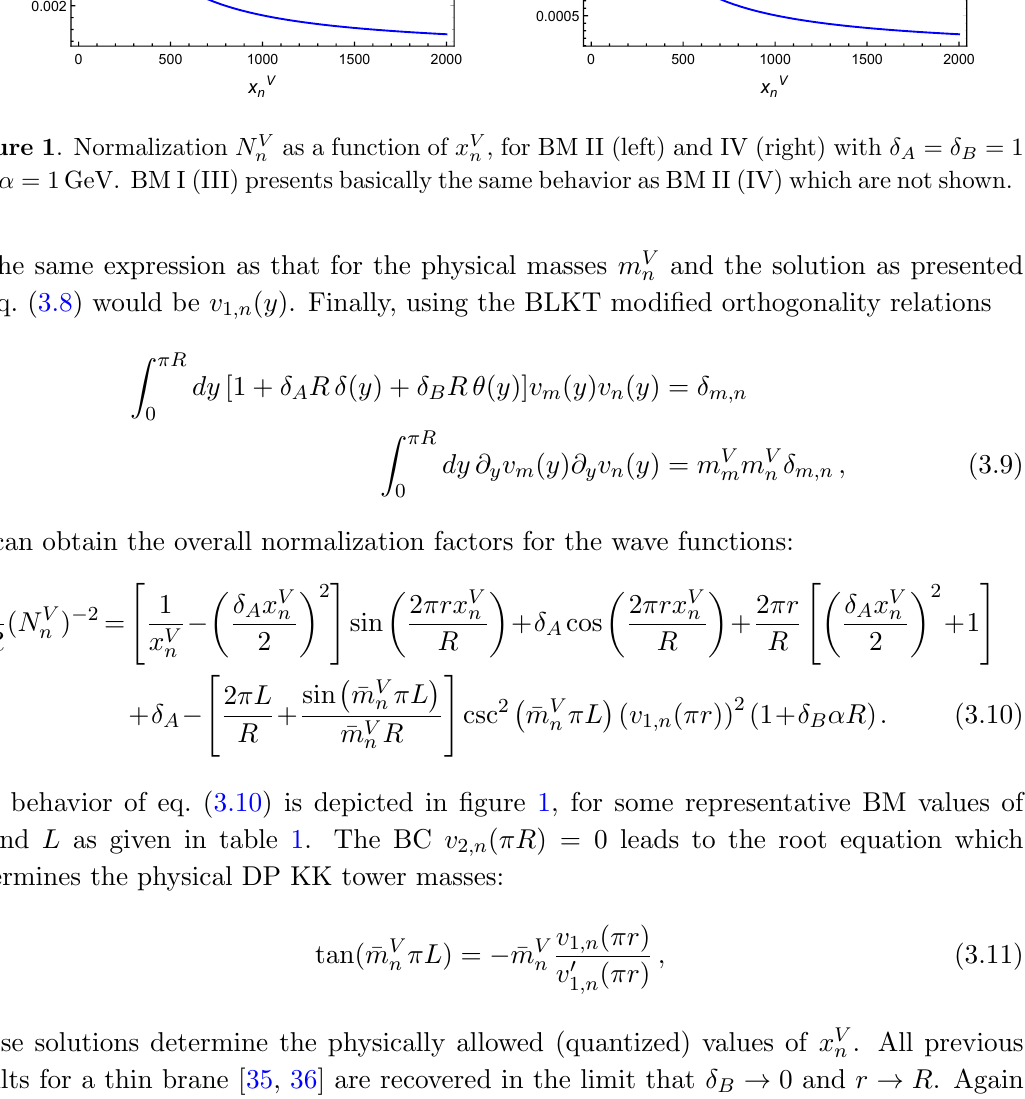
to the same expression as that for the physical masses m V